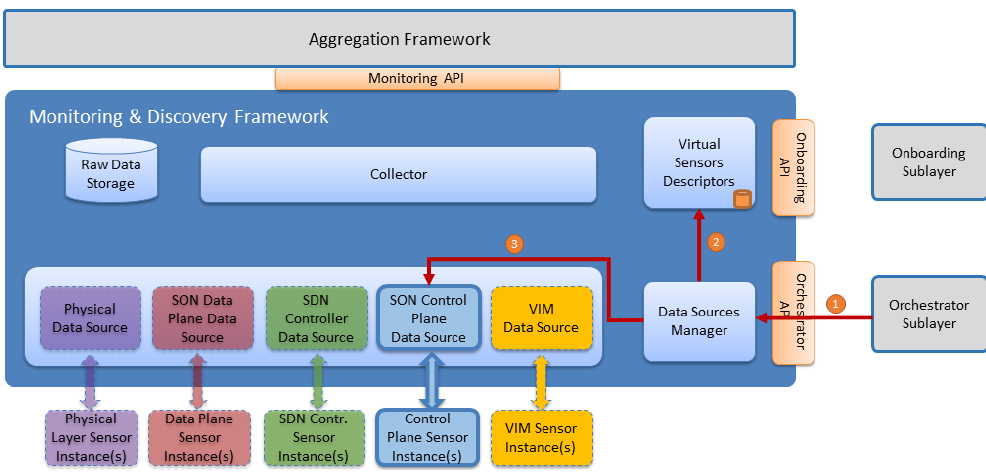
Figure 11. Sensor Monitoring—Data Source Reconfiguration Workflow.